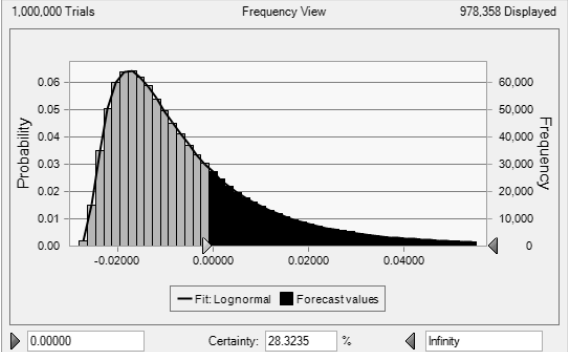
Figure 5. Simulated distribution of R for the High Speed Rail Case . Source: Own calculation applying Crystal